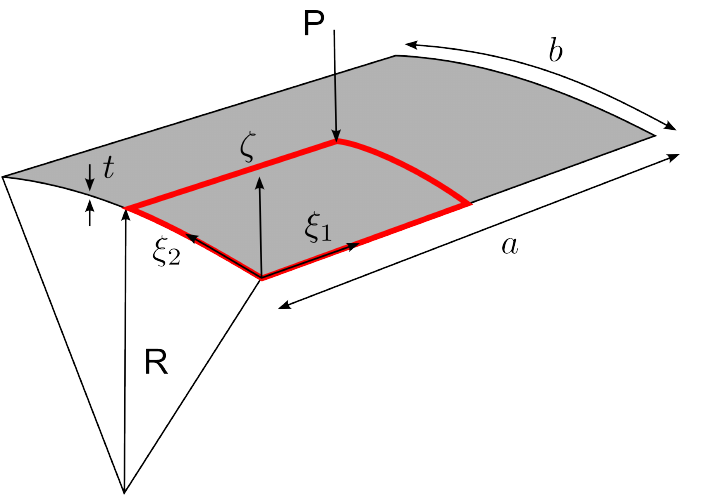
Figure 22. Geometry of cylindrical